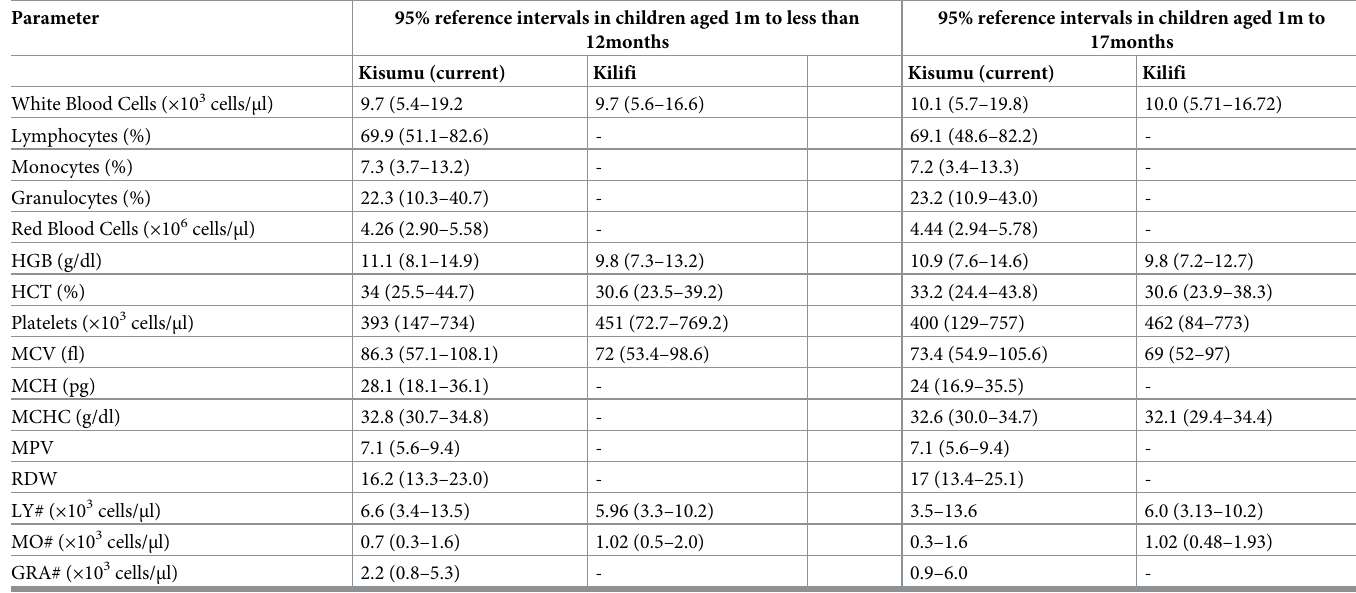
Table showing comparison of Kisumu and Kilifi hematological median values. Some parameters were not available in Kilifi data for comparison with Kisumu